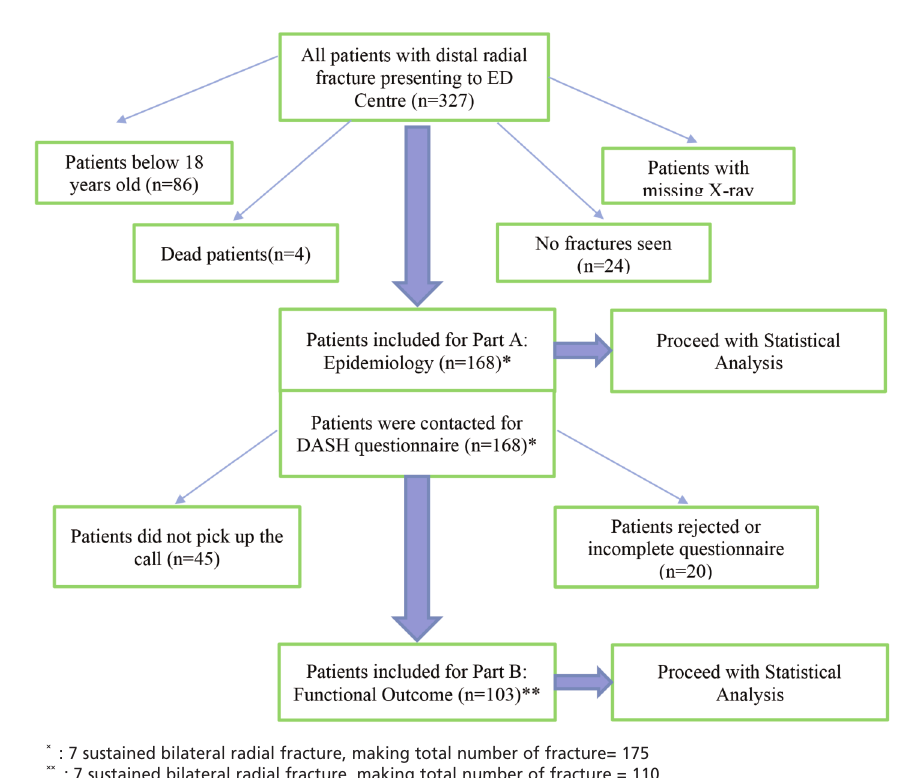
: 7 sustained bilateral radial fracture, making total number of fracture= 175 ̽ ̽ ̽ Shows the selection of the participants for the research. Fig. 1: